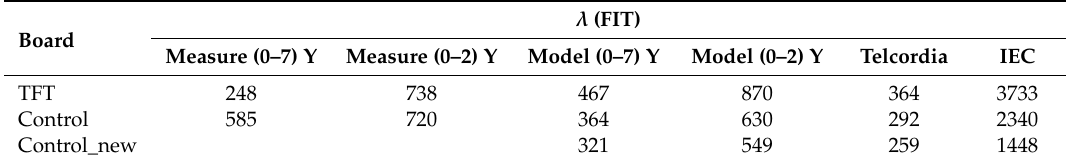
Figure 11. Contribution to the failure rate of the Control board of the different types of components, derived from experimental data. Table 3. Failure rate of four boards expressed in FIT (FIT = 1 / 10 9 h) for the four methodologies: Telcordia, IEC experimental data and our model.